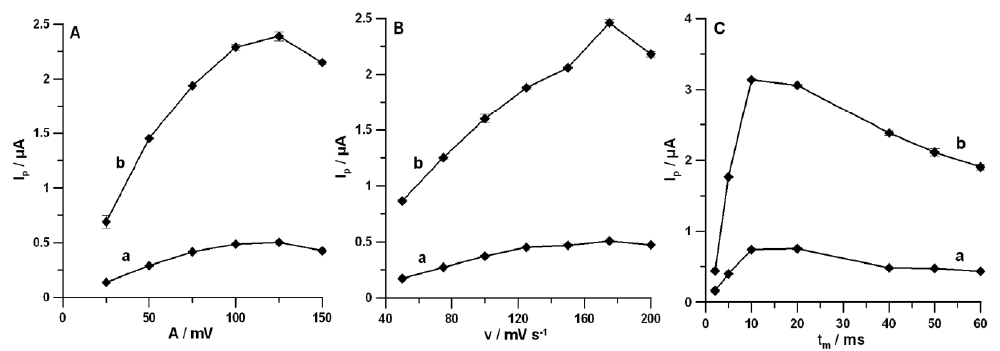
Figure 6. E ff ects of A ( A ), ν ( B ), and t m ( C ) on DF current response. Curves (a,b) are for 0.01 and 0.05 µ mol L − 1 DF, respectively. The DPAdSV parameters: ( A ) E acc of − 0.25 V, t acc of 60 s, ν of 175 mV s − 1 and t m of 40 ms; ( B ) A of 125 mV and t m of 40 ms; and ( C ) A of 125 mV and ν of 175 mV s − 1